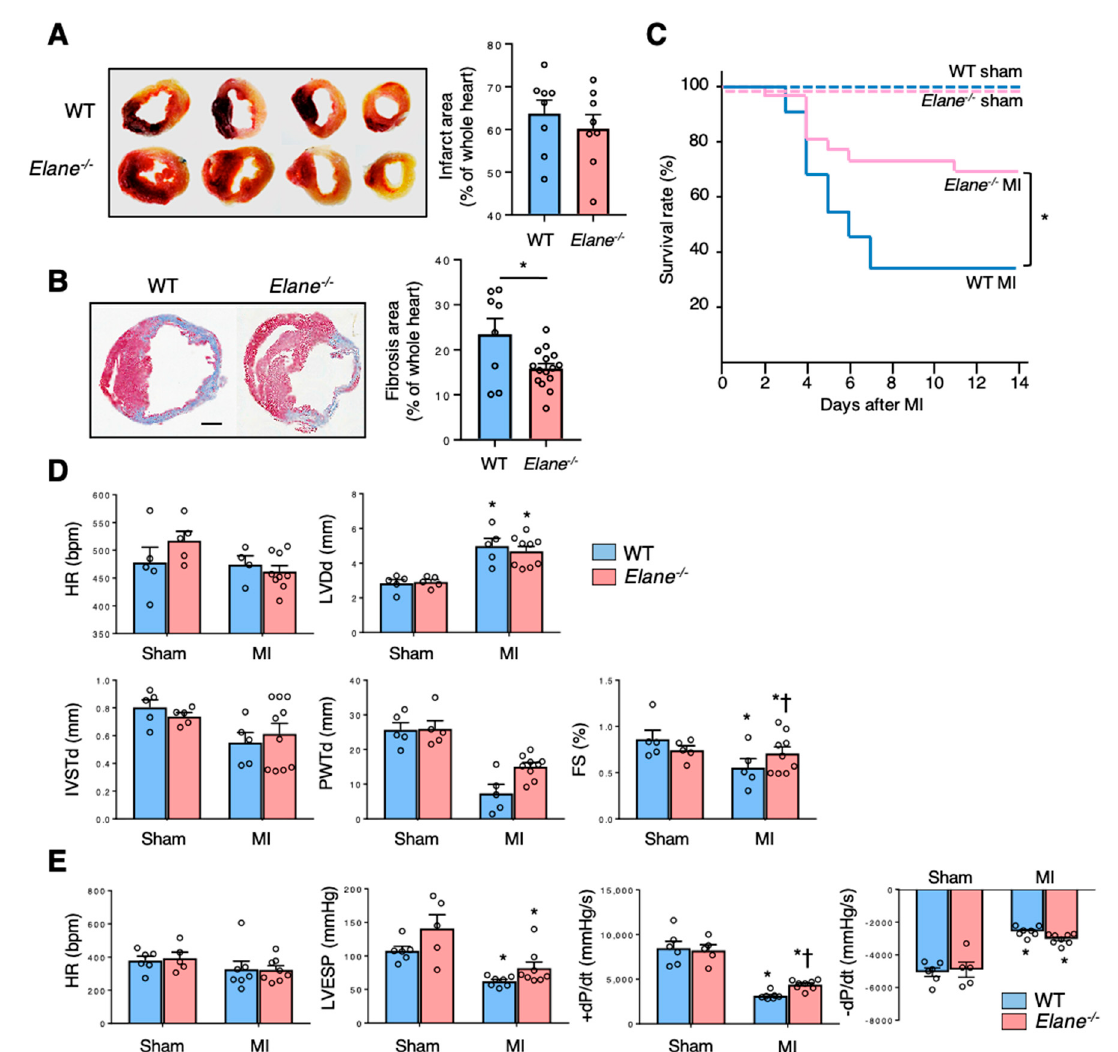
Figure 2. NE deletion improved survival and cardiac function post-MI. ( A ) Twenty-four hours post-MI, the hearts were removed and stained with 2,3,5-triphenyltetrazolium chloride for measurement of infarct area. Viable parts of the heart appear red, while the infarct area appears white. The bar graph represents quantification of infarct area as a percentage of the whole heart. Results are presented as mean ± SEM, n = 8 each. ( B ) Representative Masson’s trichrome staining images of the hearts from WT and Elane − / − mice on day 7 post-MI. The bar graph shows quantification of fibrosis area as a percentage of the whole heart. Results are presented as mean ± SEM, n = 8–15 each, * p < 0.05. ( C ) Kaplan–Meier survival analysis 14 days post-MI or sham operation. Blue line indicates WT with MI ( n = 22), red line indicates Elane − / − with MI ( n = 26), dotted blue line indicates WT with sham operation ( n = 8), and dotted red line indicates Elane − / − with sham operation ( n = 7). * p < 0.05 by log rank. ( D ) Bar graphs represent echocardiographic parameters from the indicated mice. Results are presented as mean ± SEM, n = 5–9 each, * p < 0.05 vs. sham and # p < 0.05 vs. WT. ( E ) Bar graphs represent hemodynamic parameters 14 days post-MI. Results are presented as mean ± SEM, n = 5–8 each, * p < 0.05 vs. sham and † p < 0.05 vs.